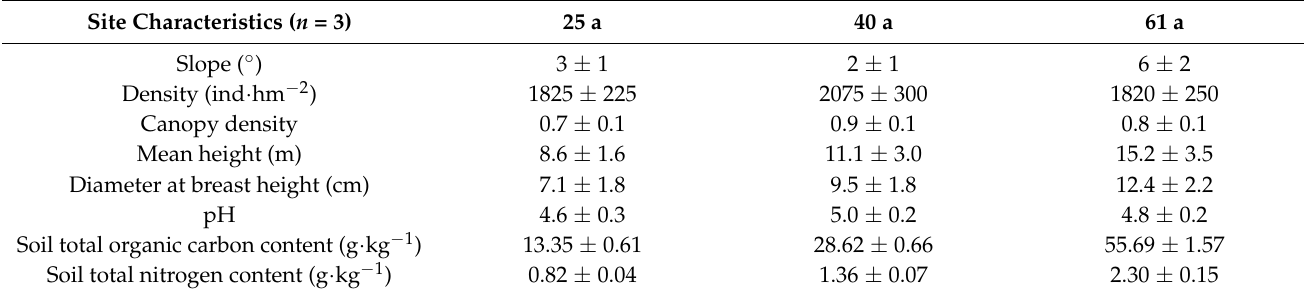
Table 1. Characteristics of three different-aged Betula platyphylla forests of the permafrost region, Northeast China. Site Characteristics ( n =